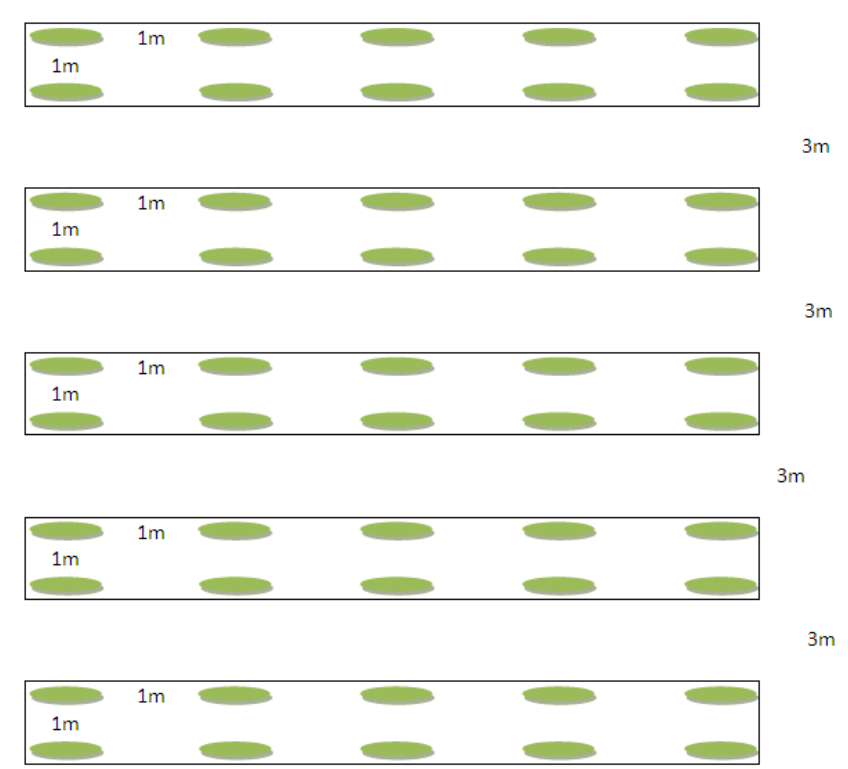
Figure 1. Seedling planting diagrams for each treatment.